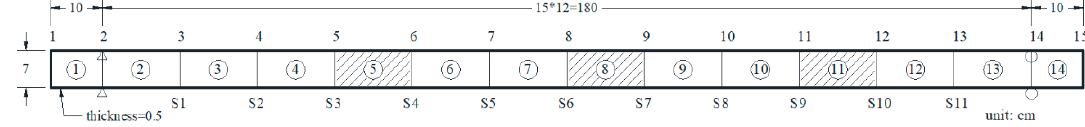
Figure 10. Simply supported beam model.